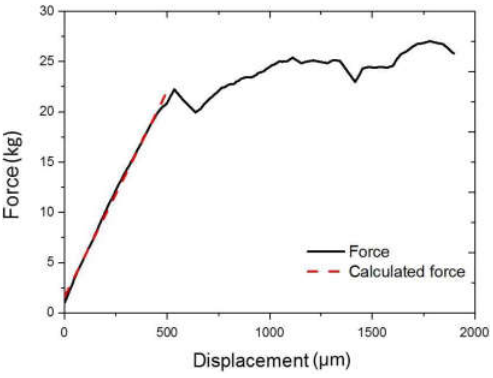
Figure 3. Shear force–displacement behavior measured for terminal-solder joints and the regression line calculated in the elastic region.